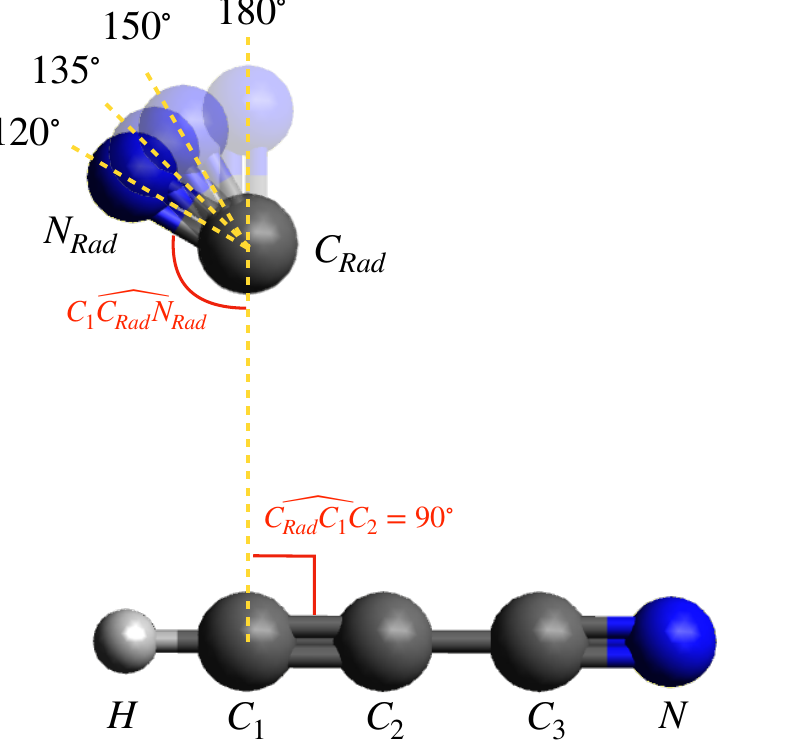
(cid:92) C 1 C Rad N Rad angles (in degrees) that where fixed to represent